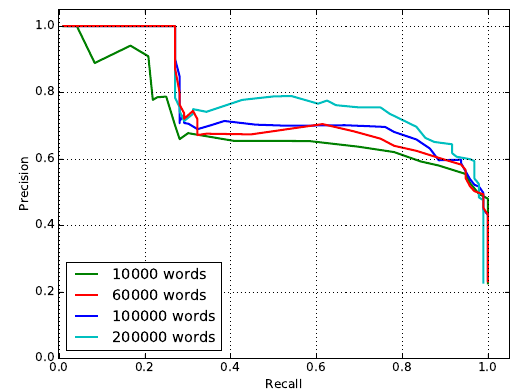
Figure 7. Precision-Recall curve for different dictionary sizes 4.2.3 Rating of potential object positions As mentioned in